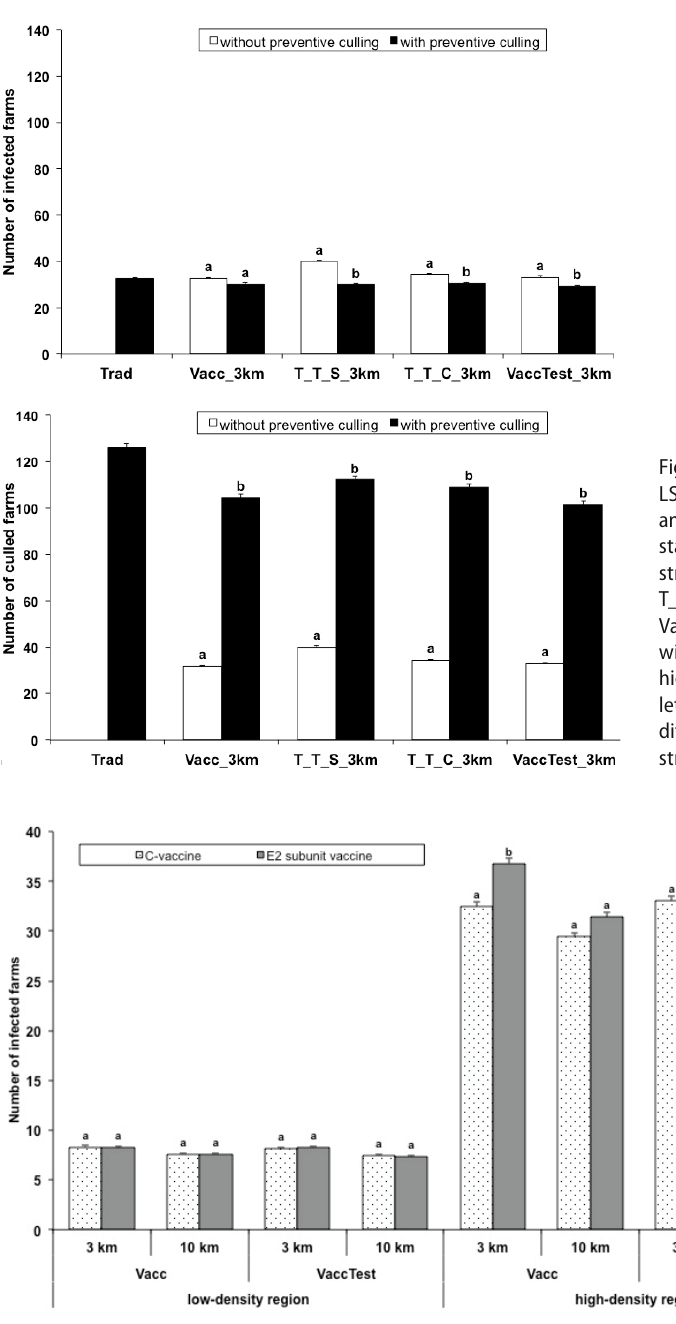
Figure 3: LSM number of infected farms and their standard error using a C-vaccine or an E2 subunit vaccine in the control strategies Vacc and VaccTest either in a 3 km or a 10 km application radius (Different letters indicate significant differences within region, control strategy and application radius,